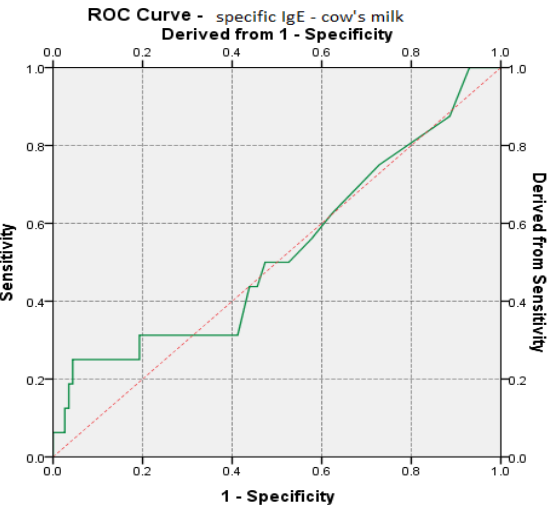
Figure 4. ROC (receiver operating characteristic) curve for egg white specific IgE prediction vs. remission of the disease.